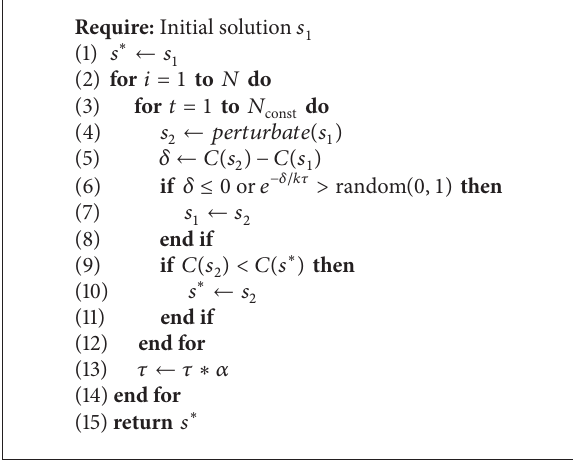
Table 1: Simulated annealing parameters.